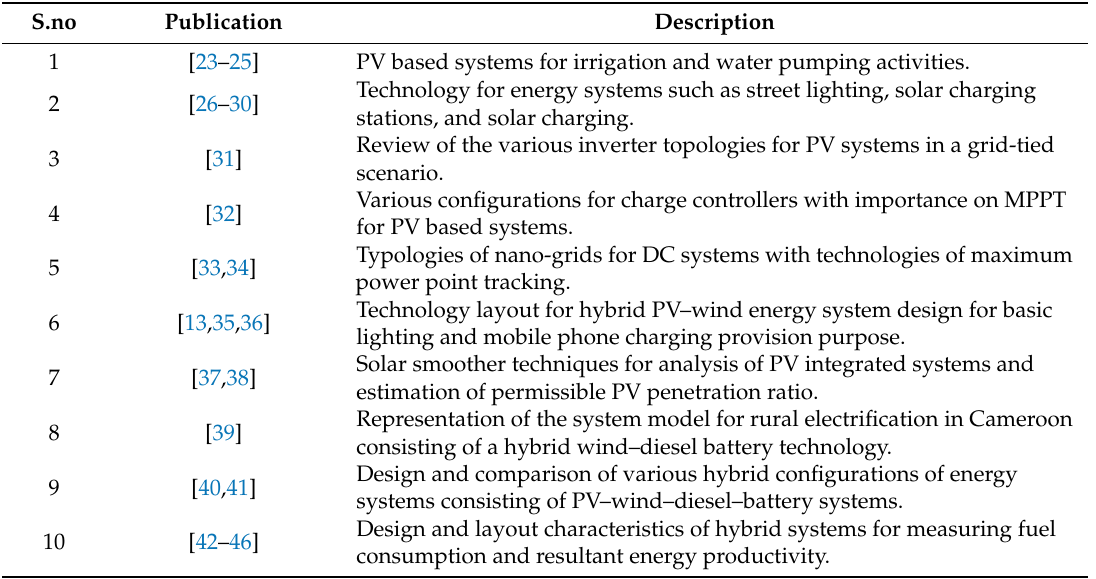
Table 2. Microgrid technology layout for o ff -grid systems (stand-alone and hybrid).